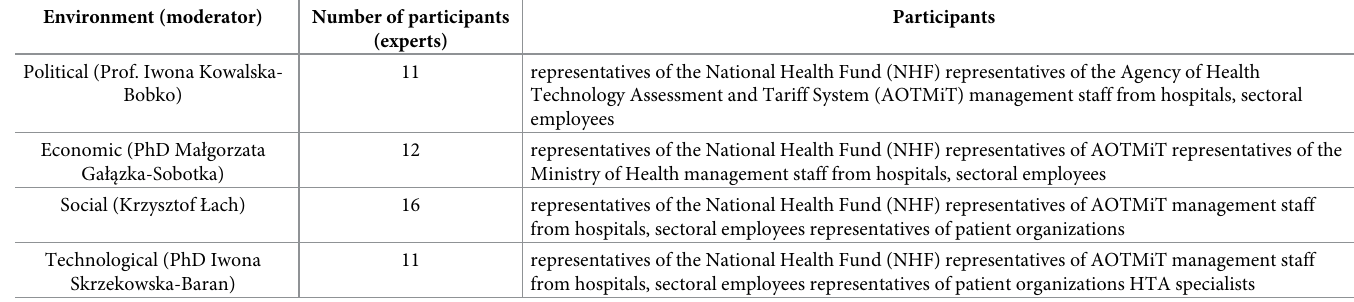
Table 1. Sample size and moderators.